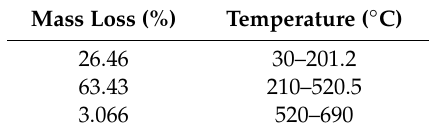
Figure 6. IR spectrum of as ‐ synthesized surfactant in hyphenated TG ‐ IR (curve 2).